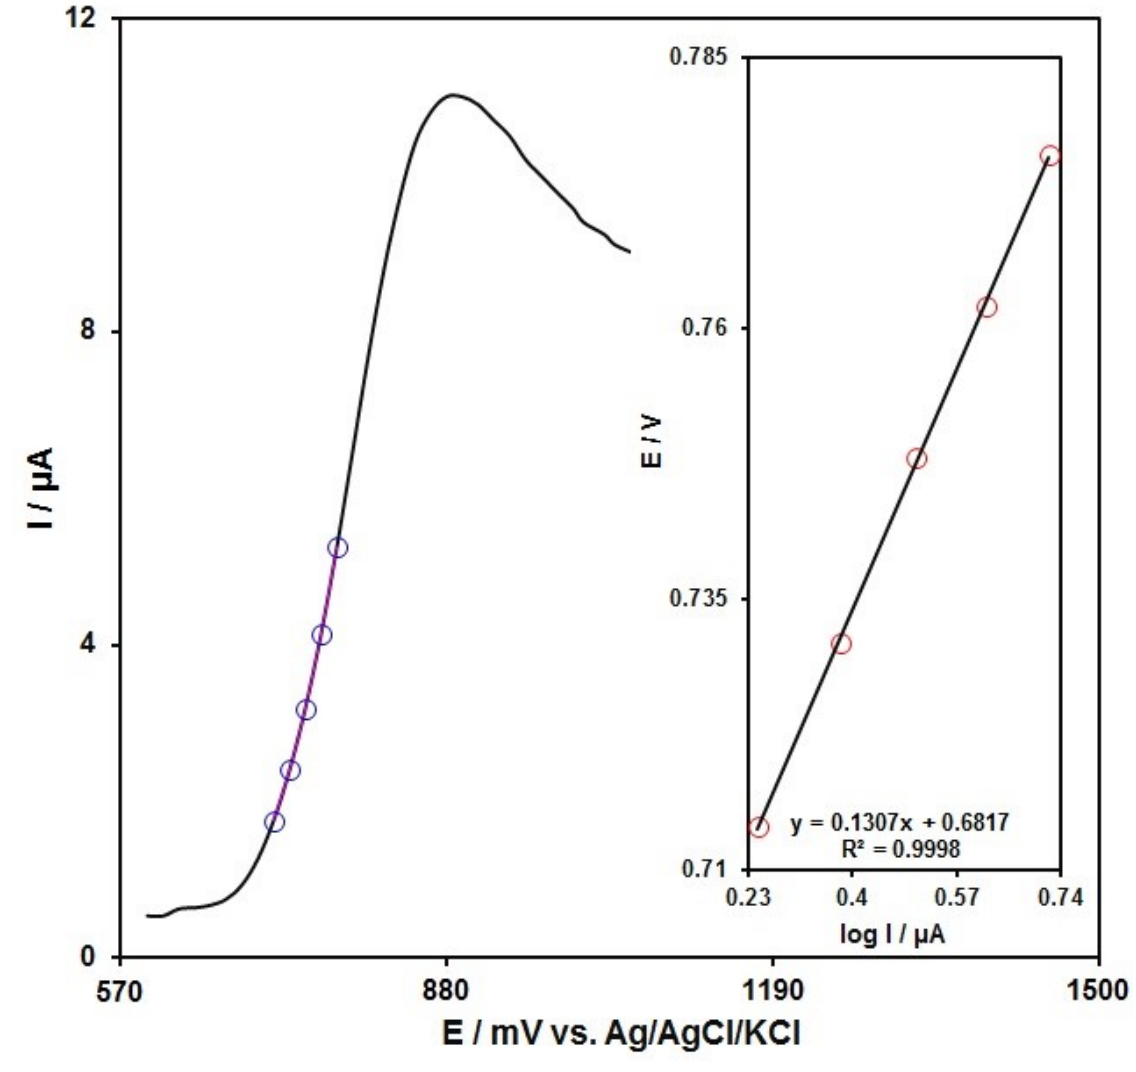
Figure 8. LSV captured for MnO 2 NR-IL/CPE in PBS (0.1 M) at the optimized pH value of 7.0 under exposure to 50.0 µ M of SAA at 10 mV/s; Points: information applied in the Tafel plot; Inset: LSV-derived Tafel plot.